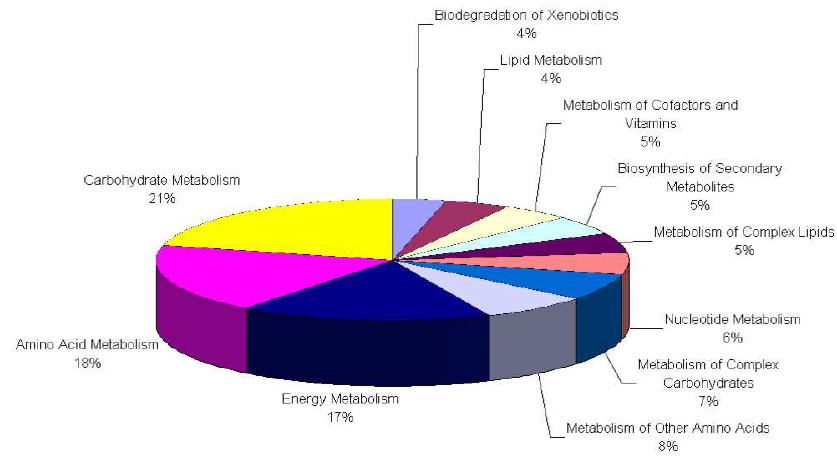
Figure 3: mapping of ESTs from the CR-EST database to GO